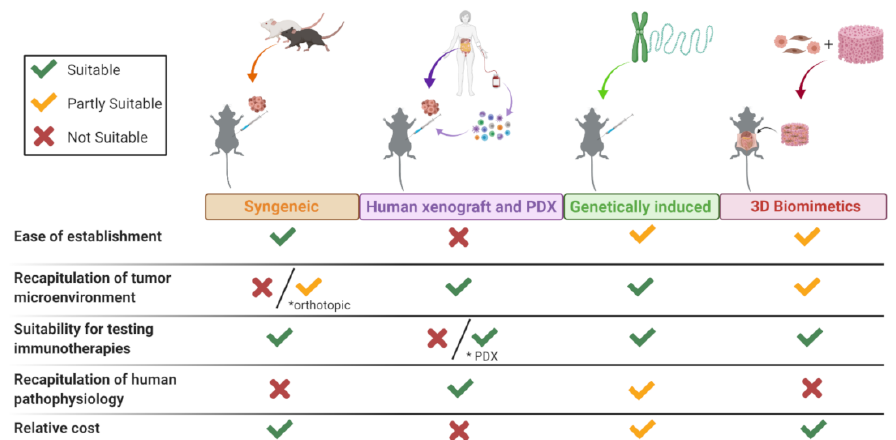
Figure 3. Benefits and limitations of PCa mouse models. Assessment of the current platforms for preclinical development of anticancer drugs or immunotherapeutic agents in PCa. Relative scores are represented as being suitable (green checkmark), partially suitable (yellow checkmark), and not suitable (red cross). Created with BioRender.com, accessed on 19 February